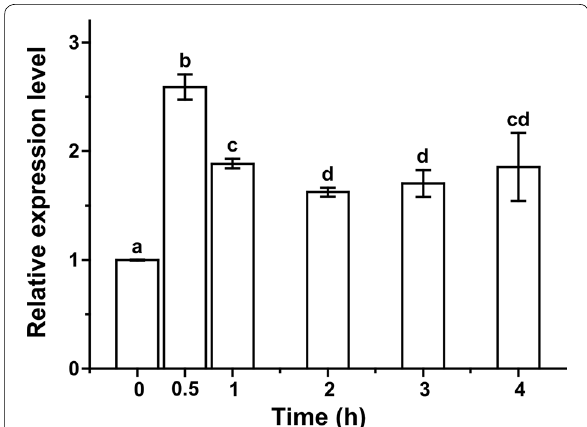
Fig. 3 Expression profile of hmhsp70 under heat stress. Mycelia of H. marmoreus were treated at 42 °C for 0, 0.5, 1, 2, 3 and 4 h. The 18S rRNA gene was used as an internal control. Each value is the mean from three parallel replicates SD. One-tailed t test, performed ± by SPSS 18.0 (Chicago, Illinois), was used to calculate statistical significance. Different letters indicate a significant difference at P < 0.05